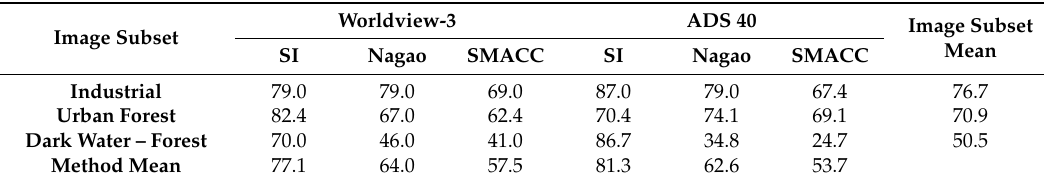
Table 6. Overall accuracy results for all three methods on both ADS40 and Worldview-3 images that includes method mean and image subset mean.